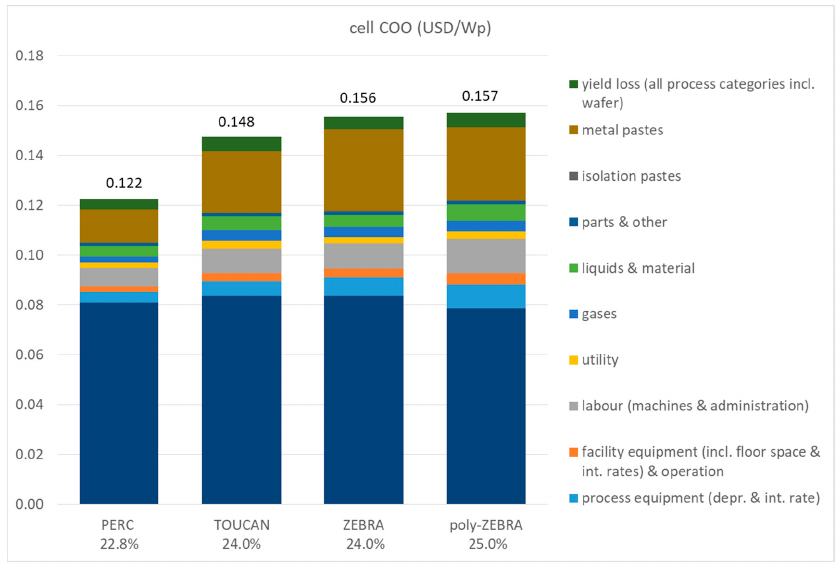
Figure 12. COO of different solar cell technologies and their energy-conversion efficiencies.